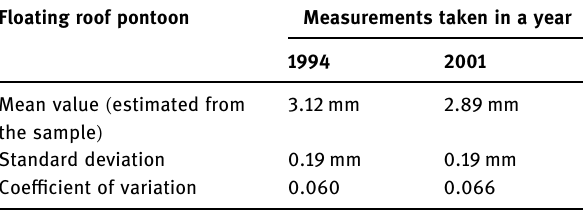
Table 7: Changes in time of statistical parameters of